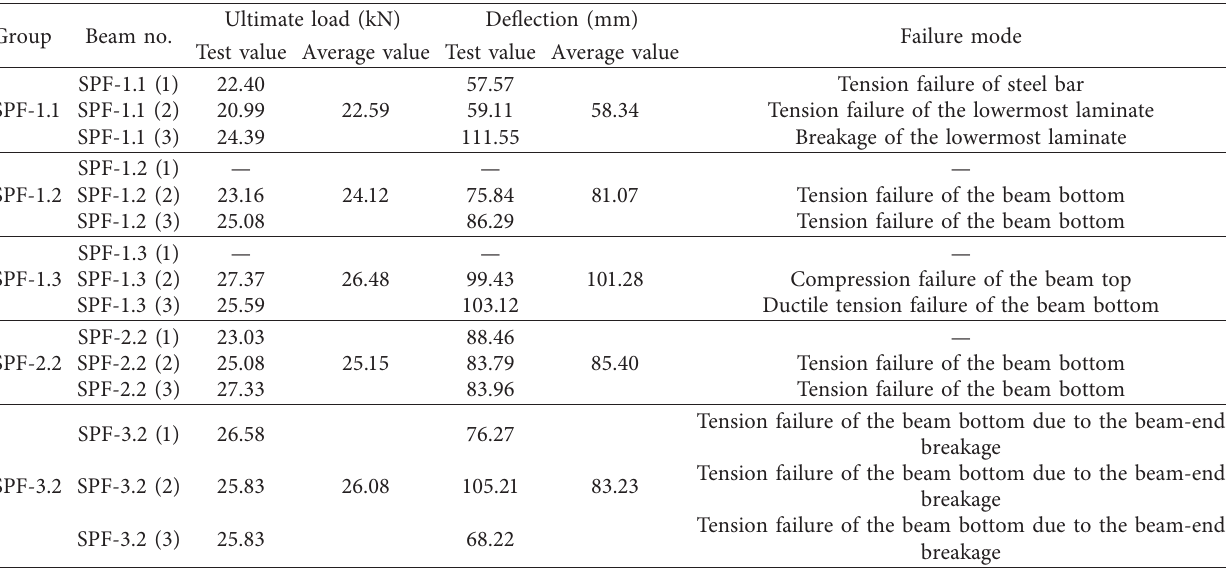
Table 2: Ultimate load, deflection, and failure mode of test beams. Group Beam no.